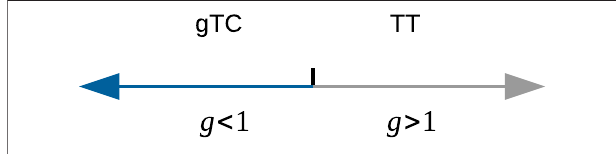
FIGURE 2 | Time order phase diagram for the quantum Rabi model, where TT and gTC, respectively, denote time trivial and generalized time crystalline